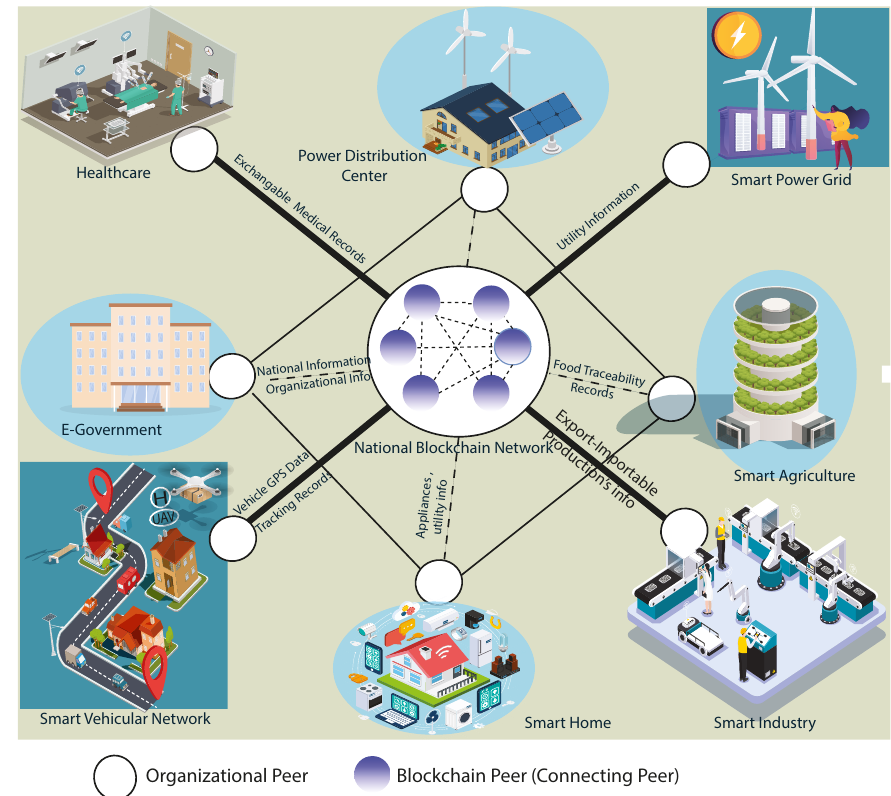
Figure 2. Interoperability of